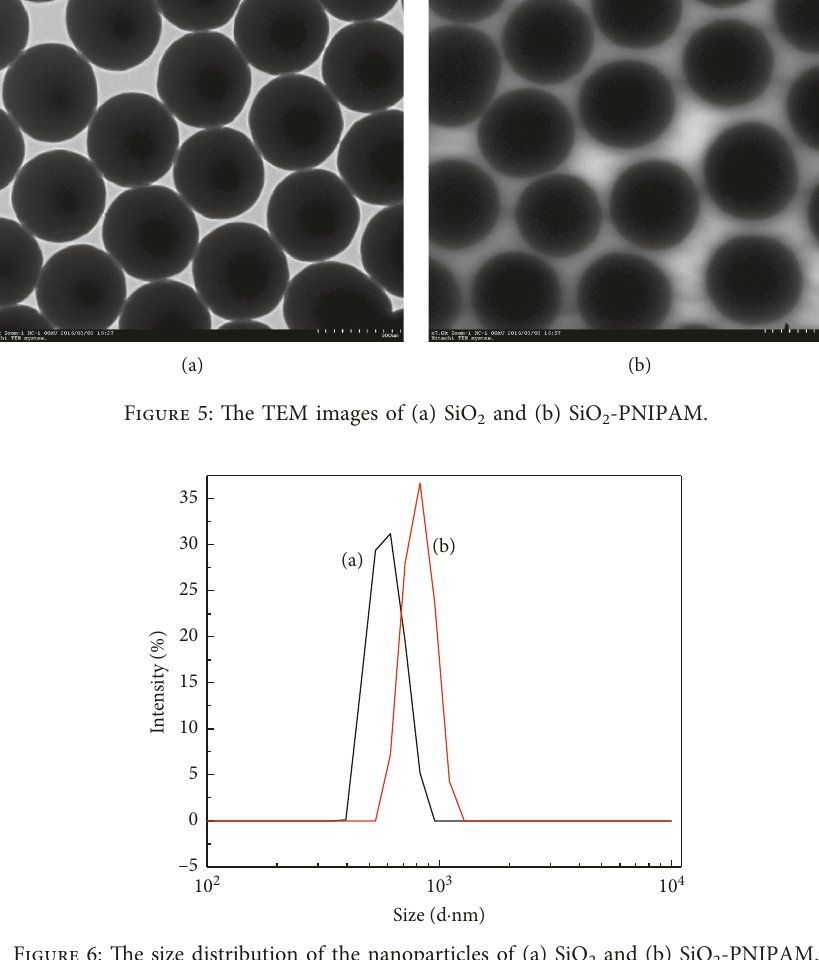
2 and (b) SiO 2 -PNIPAM.